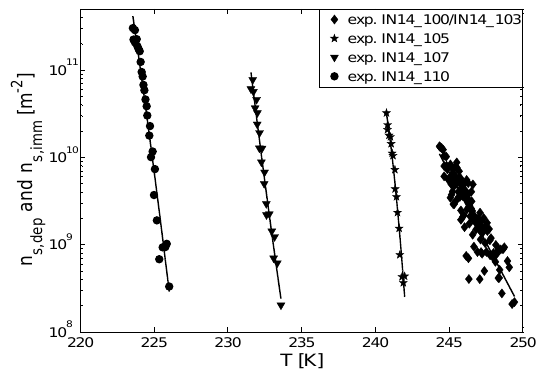
Fig. 6. Ice-active surface site densities for immersion freezing of volcanic ash particles (EY01) with fit (—) and measurement uncer- tainties (- -).